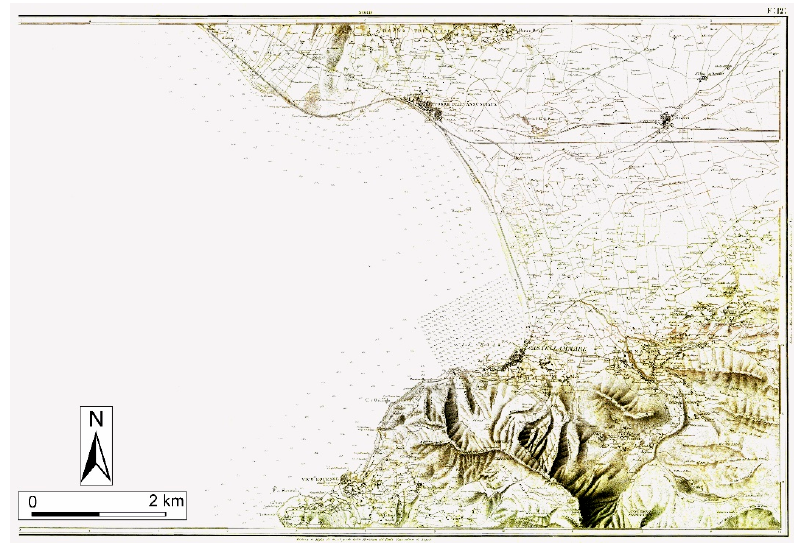
Figure 4. Historical map (year 1865) at a 1:25,000 scale. Please note that the Torre Annunciata harbor (today Torre Annunziata) is not present in the map.